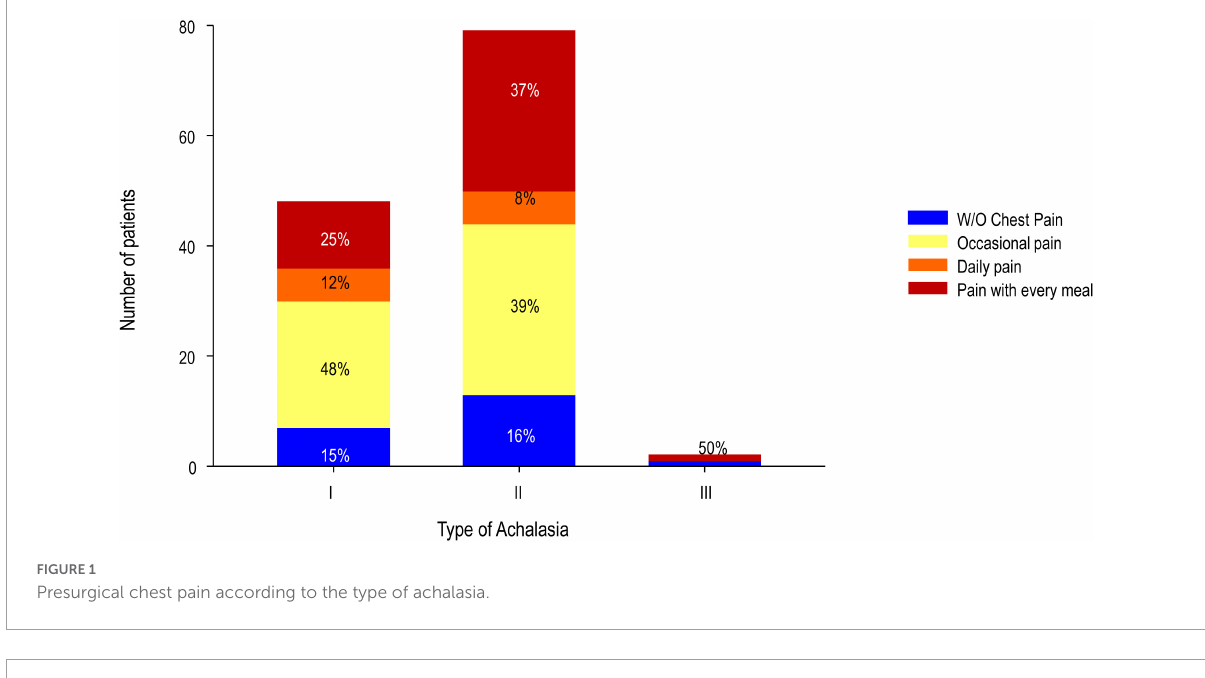
FIGURE1 Presurgical chest pain according to the type of achalasia.